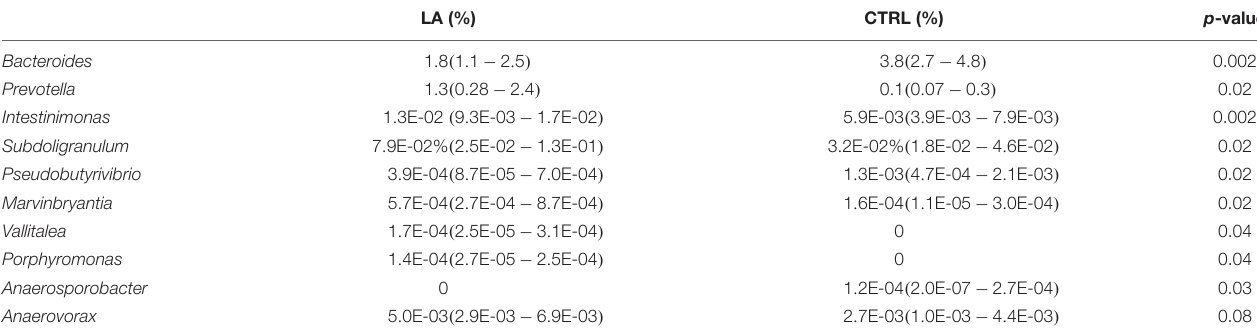
TABLE 4 | Set of microbial taxa (genus) differentially present in lifelong athletes (LA), and the sedentary elderly (CTRL). LA